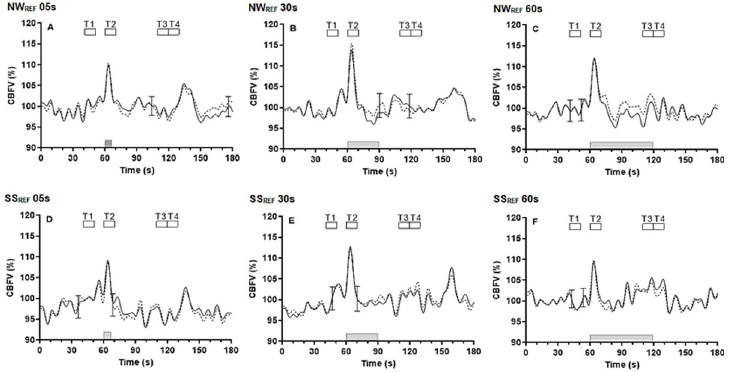
Fig 3. Average population responses (n = 16) in the right (continuous line) and left (dashed line) hemispheres for the duration of NW REF ; R-word (A, B, C) and SS REF ; 100–7 (D, E, F) paradigms of CBFV, respectively. Error bar represents the largest ± SD at the point of occurrence. Changes are shown before, during (grey bar) and after each duration of 05s of NW REF (A), 30s of NW REF (B), 60s of NW REF (C), 05s of SS REF (D), 30s of SS REF (E) and 60s of SS REF (F). Responses were synchronized by the beginning of stimulation, set at 60s. For statistical analyses, shorter segments (T1-T4) were averaged from 40-50s (T1), 60-70s (T2), 110-120s (T3) and 120-130s (T4),